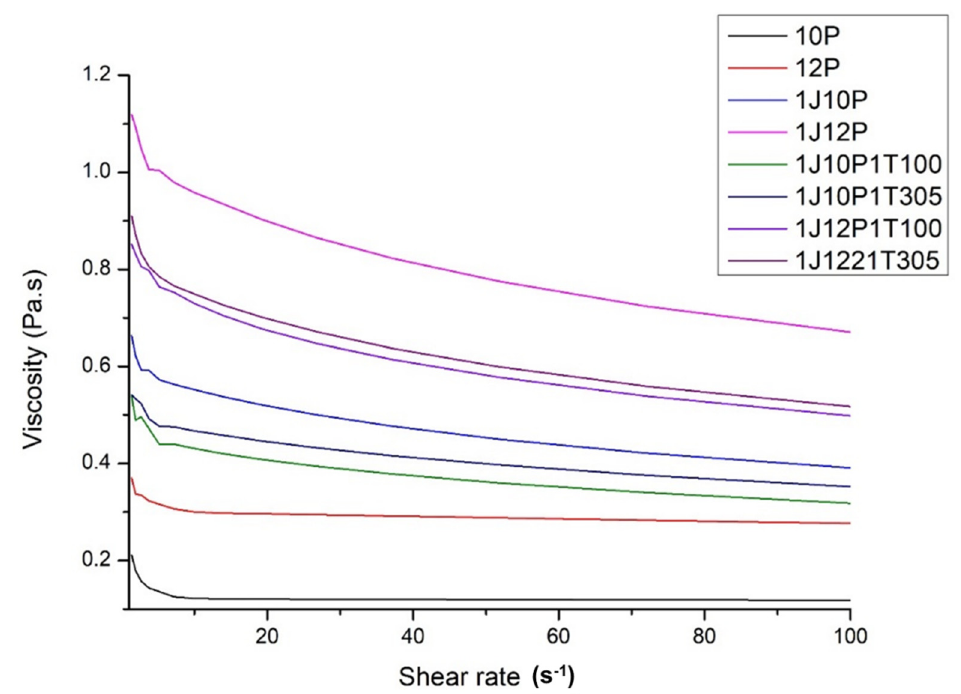
Figure 1. Viscosity as a function of a steady shear rate for various concentrations of jelly fig polysaccharide (JFP) and pullulan.